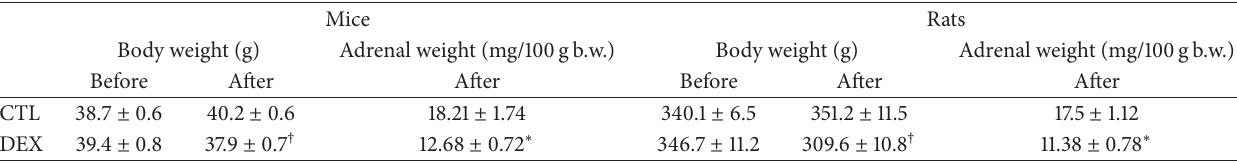
Table 1: Body and adrenal weight in DEX-treated mice and rats.